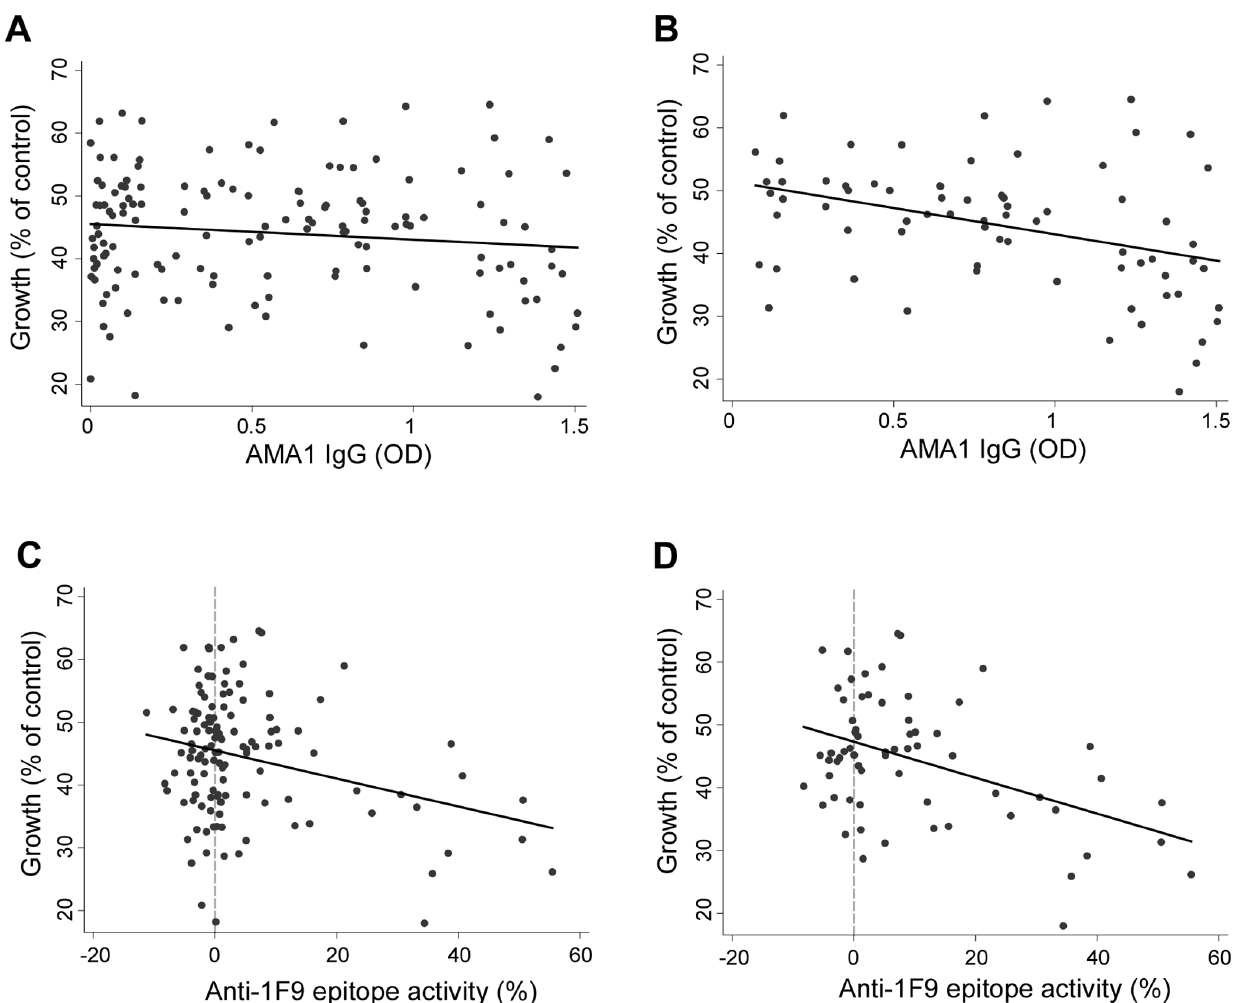
Figure 3. Association between antibody reactivity to AMA1 epitopes and P.falciparum growth in the Ngerenya cohort. ( A ) AMA1 antibody levels versus parasite growth for all samples (Spearman rank correlation, r=0.09; P=0.311), ( B ) AMA1 antibody levels and parasite growth for samples that were classified as high responders to schizont protein extract (antibody reactivity above the median), as a measure of higher exposure to blood-stage P. falciparum (r= 2 0.39; P=0.001), ( C ) Anti-1F9 epitope activity (percentage inhibition of 1F9 mAb binding) and parasite growth in all samples (r= 2 0.11; P=0.239). Positive 1F9 inhibition was defined as inhibition of 1F9 binding . (mean + 2 standard deviations of negative controls=6.19%). ( D ) Anti-1F9 epitope activity (percentage inhibition of 1F9 mAb binding) and parasite growth in samples with high levels of antibodies to AMA1 (defined as antibody levels above the median value of the group) (r= 2 0.25; P=0.042). Parasite growth is expressed relative to controls (PBS). IgG binding to AMA1 is expressed as optical density (OD). Antibodies to the 1F9 epitope are expressed as a percentage of control (serum from malaria-naı¨ve donors).